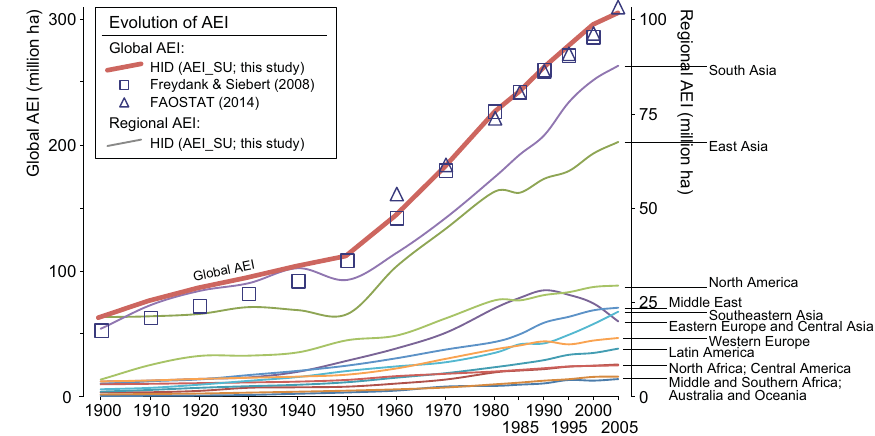
Figure 3. Evolution of regional (thin lines; right y axis) and global (thick line and symbols; left y axis) area equipped for irrigation (AEI) for the 20th century based on the sub-national historical irrigation statistics (AEI_SU) collected for the historical irrigation data set (HID), and of global AEI in Freydank and Siebert (2008) and FAOSTAT (FAO, 2014b).